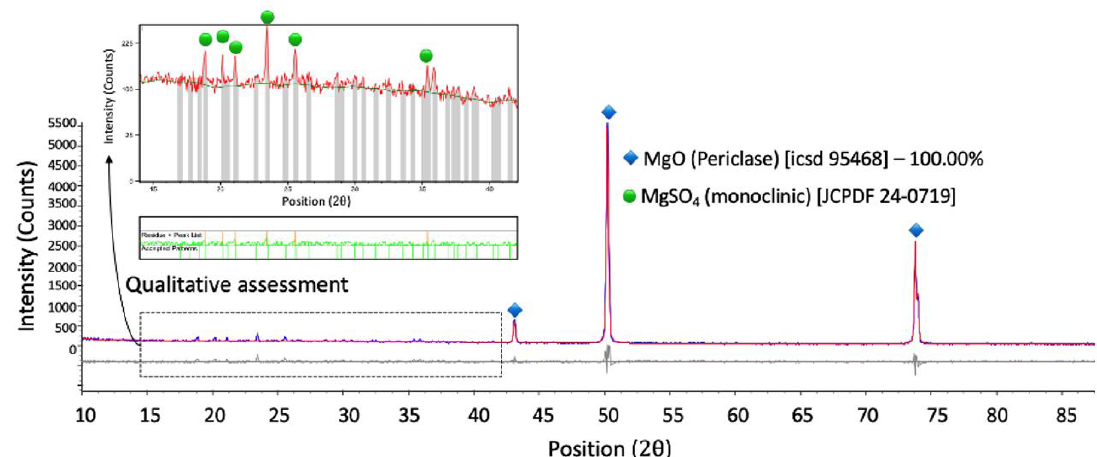
without Pd/Al 4